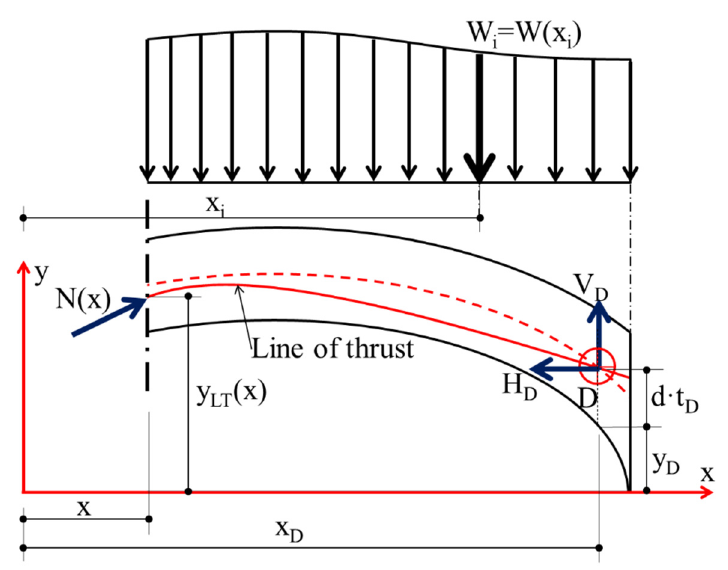
Figure 3. Line of thrust in the arch.